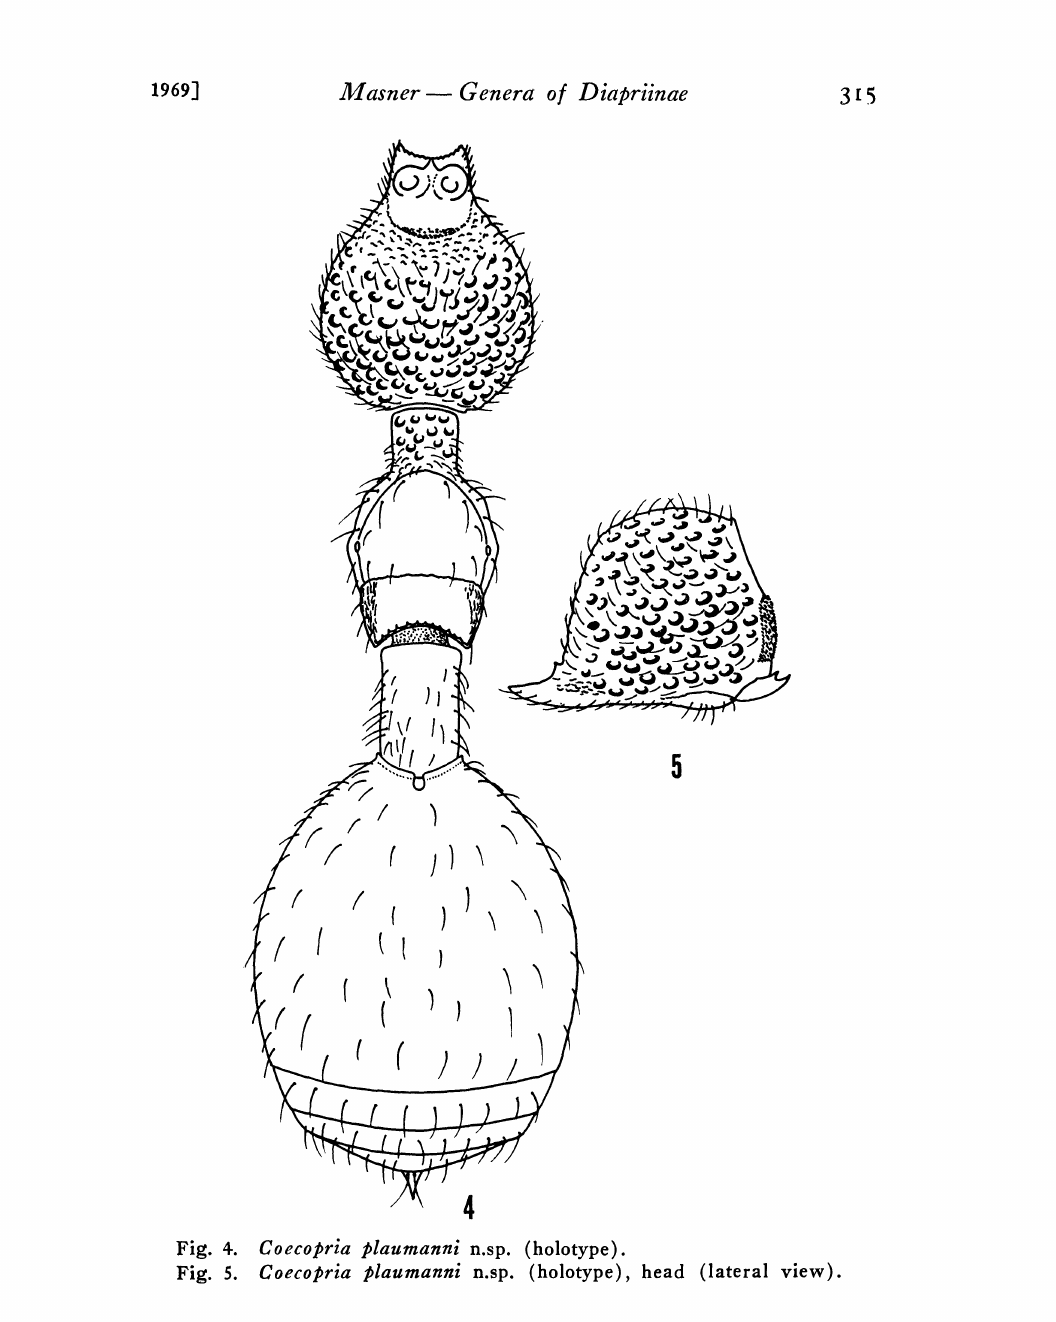
Fig. 4. Coecopria laumanni n.sp. (holotype). Fig. 5. Coecolria #laumanni n.sp. (holotype), head (lateral